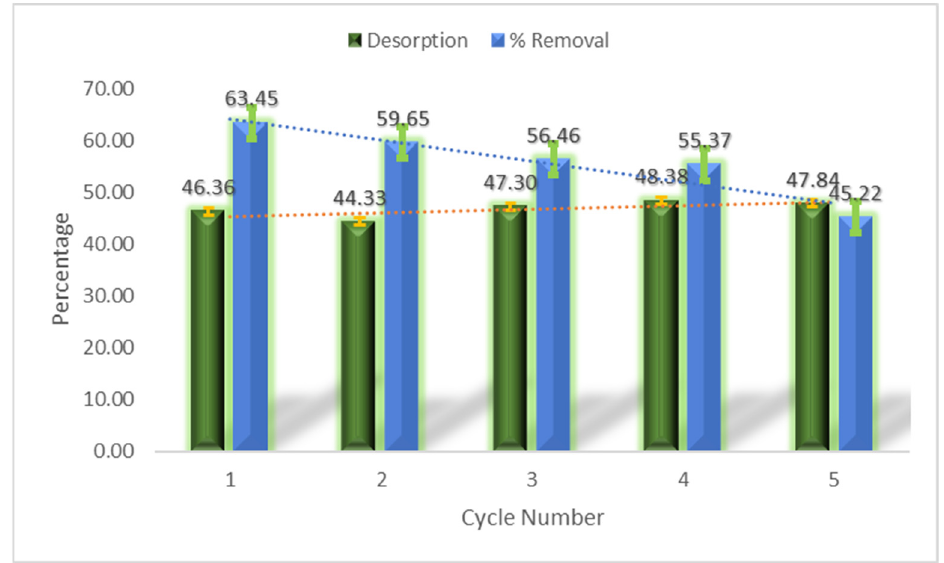
Figure 9. Regeneration of the adsorbent after 5 adsorption–desorption cycles.